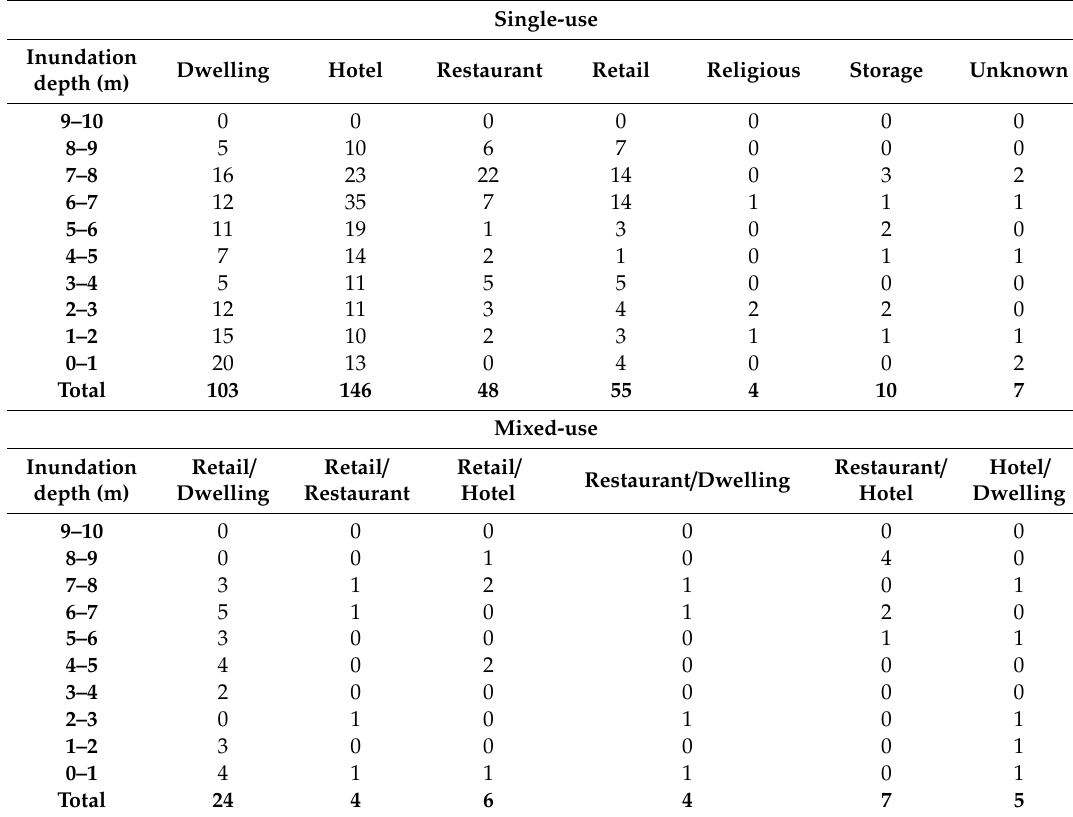
Table 2. Use of buildings in relation to inundation